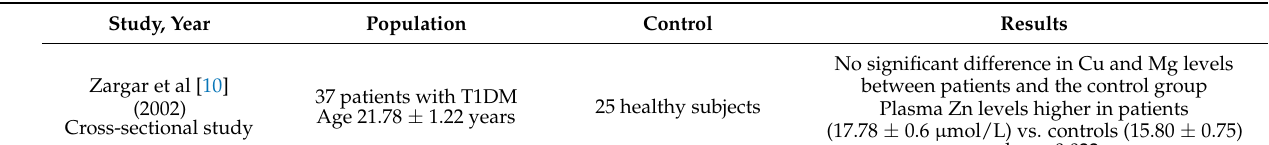
Table 3. Copper in T1DM patients. Cu, Copper; T1DM, Type 1 Diabetes Mellitus; T2DM, Type 2 Diabetes Mellitus; Zn,